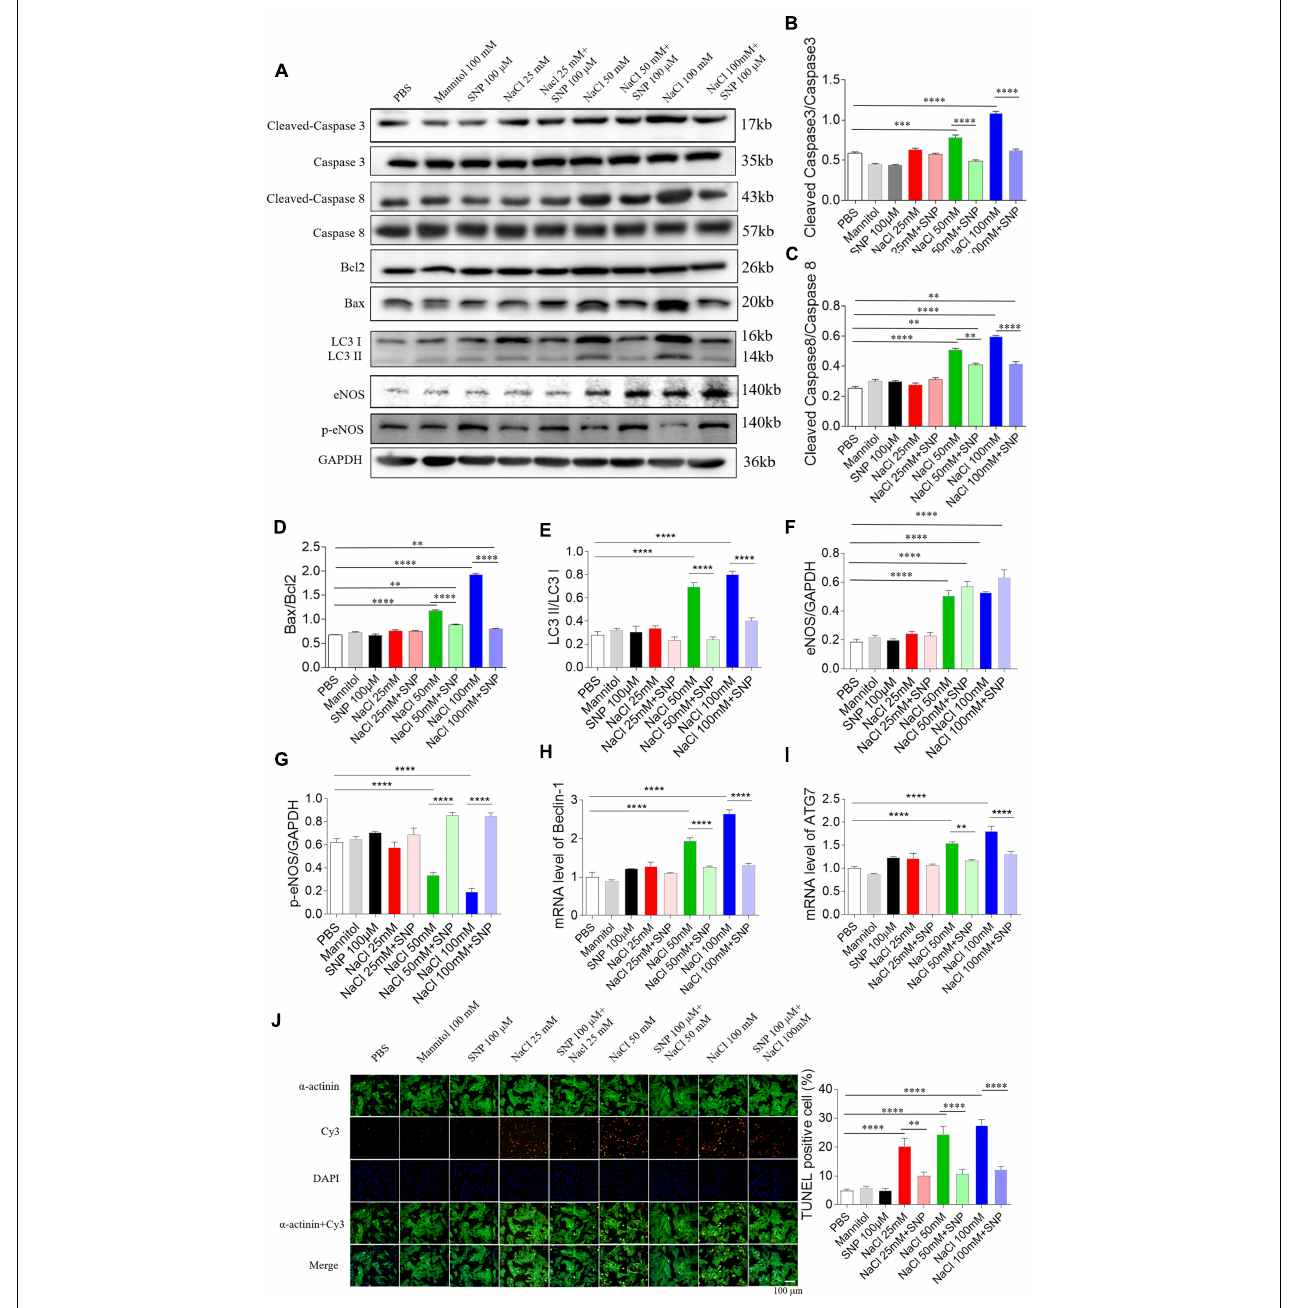
FIGURE 6 | Effects of nitric oxide donor sodium nitroprusside (SNP) on apoptosis and autophagy induced by three doses of sodium chloride (NaCl) in H9C2 cells. (A–I) SNP (100 µ M) attenuated the increases in the levels of cleaved-caspase 3/caspase 3, cleaved-caspase 8/caspase 8, and Bax/Bcl2 induced by NaCl (50 or 100 mM) in H9C2 cells. (F) The increases of TUNEL-positive cell numbers induced by three doses of NaCl in the H9C2 were attenuated by SNP (100 µ M) treatment. The results are expressed as mean ± SEM. * p < 0.05, ** p < 0.01, *** p < 0.001, and **** p <